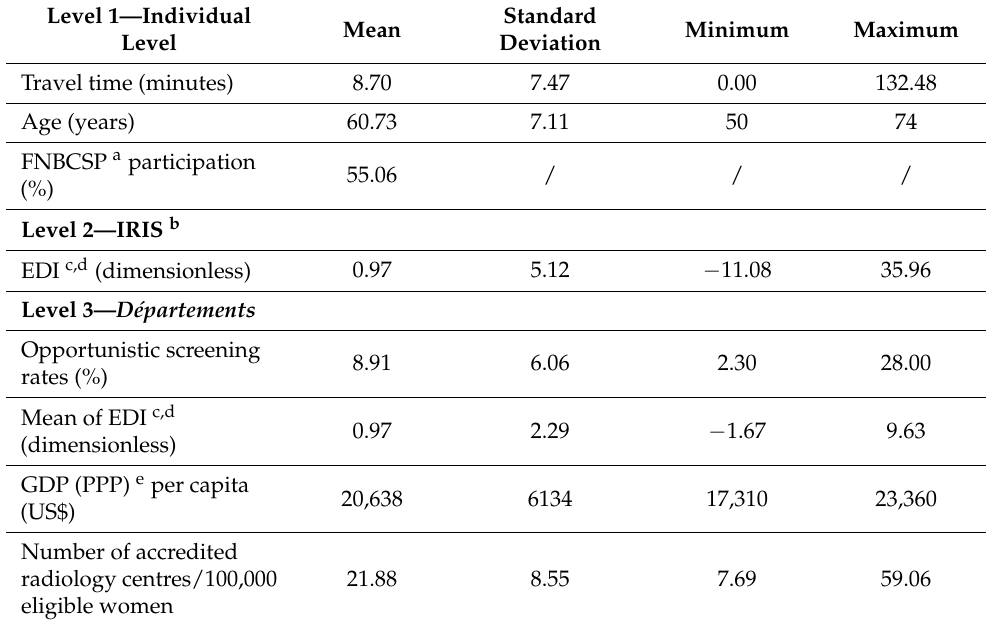
Table 1. Characteristics of the